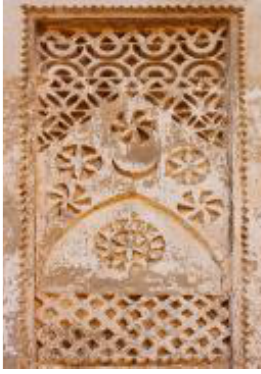
(Figure. 9) A plaster decorated unit common in the heritage architecture using the Najdi